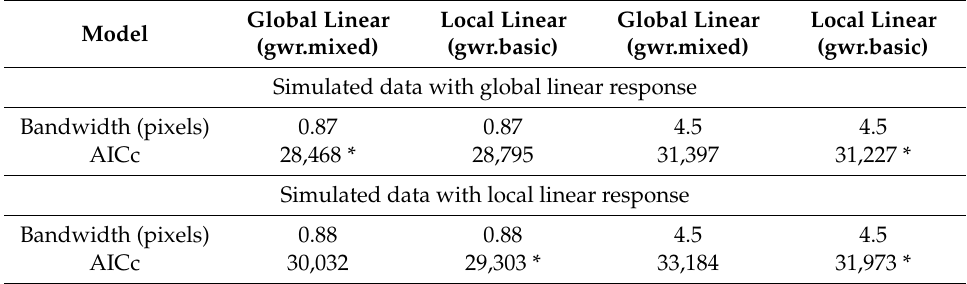
Table 3. AICc for models of increasing order of complexity fitted to data with simulated global and locally varying linear response (minimum values of AICc identify optimal models; these are marked with asterisks, *).